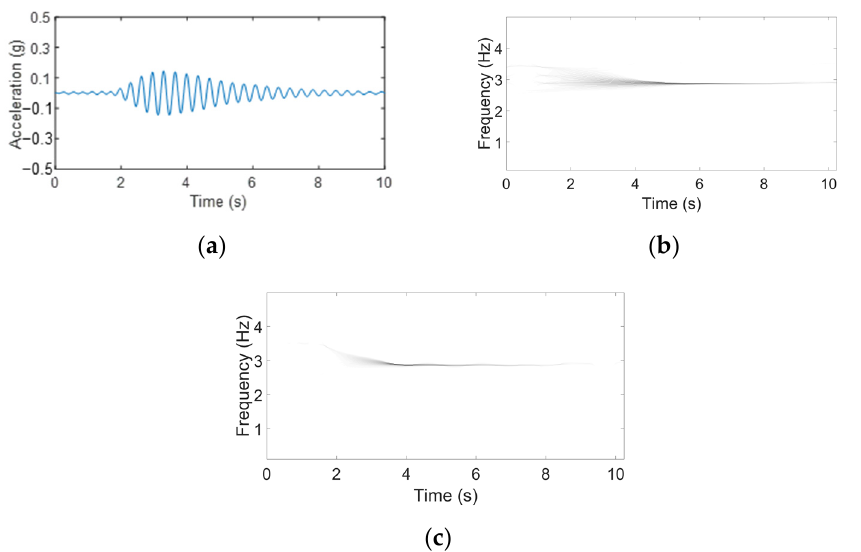
Figure 18. Decomposed acceleration for the dominant mode of vibration: ( a ) acceleration time history; ( b ) SSAWT; ( c ) FIrST.